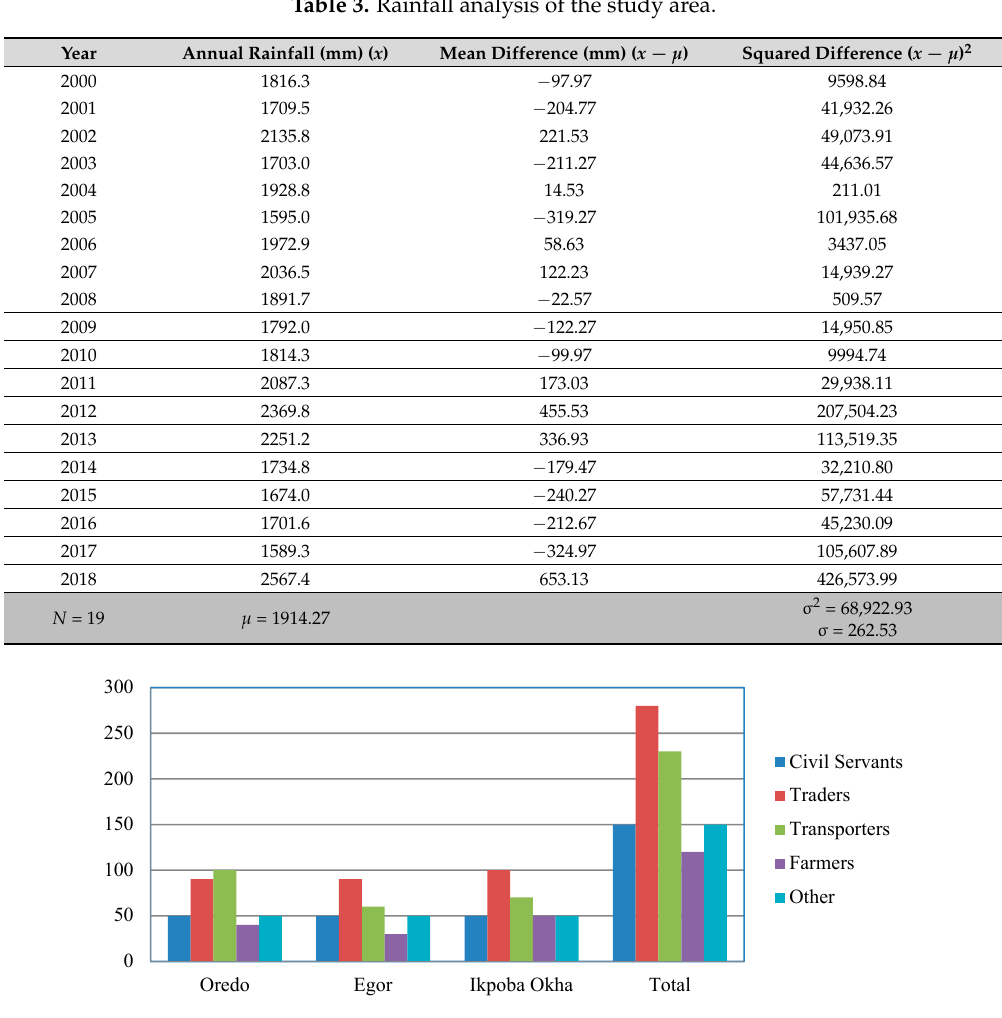
Figure 2. Different occupational groups within the study area.